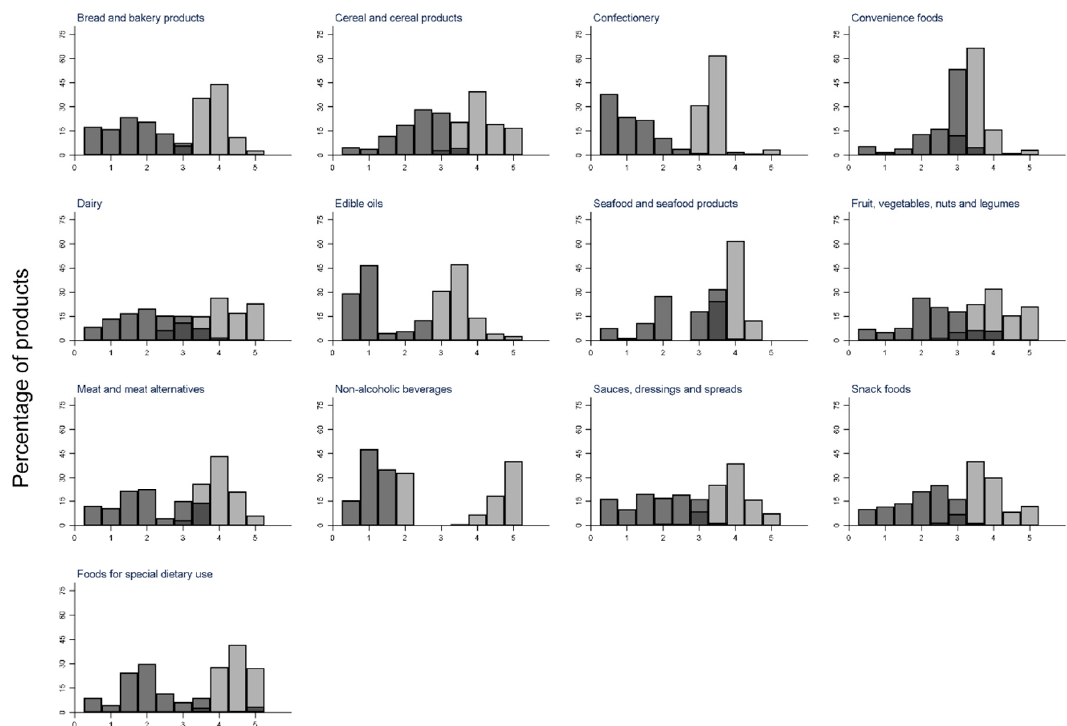
Figure 2. Health Star Rating distribution of products eligible (light grey) and ineligible (medium grey) to display a health claim, by major food category. Dark grey indicates overlap between products eligible and ineligible to display a health claim.